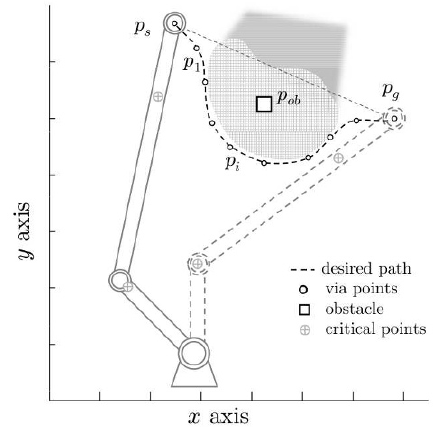
Figure 1. Construction of a path with n via points in 2D